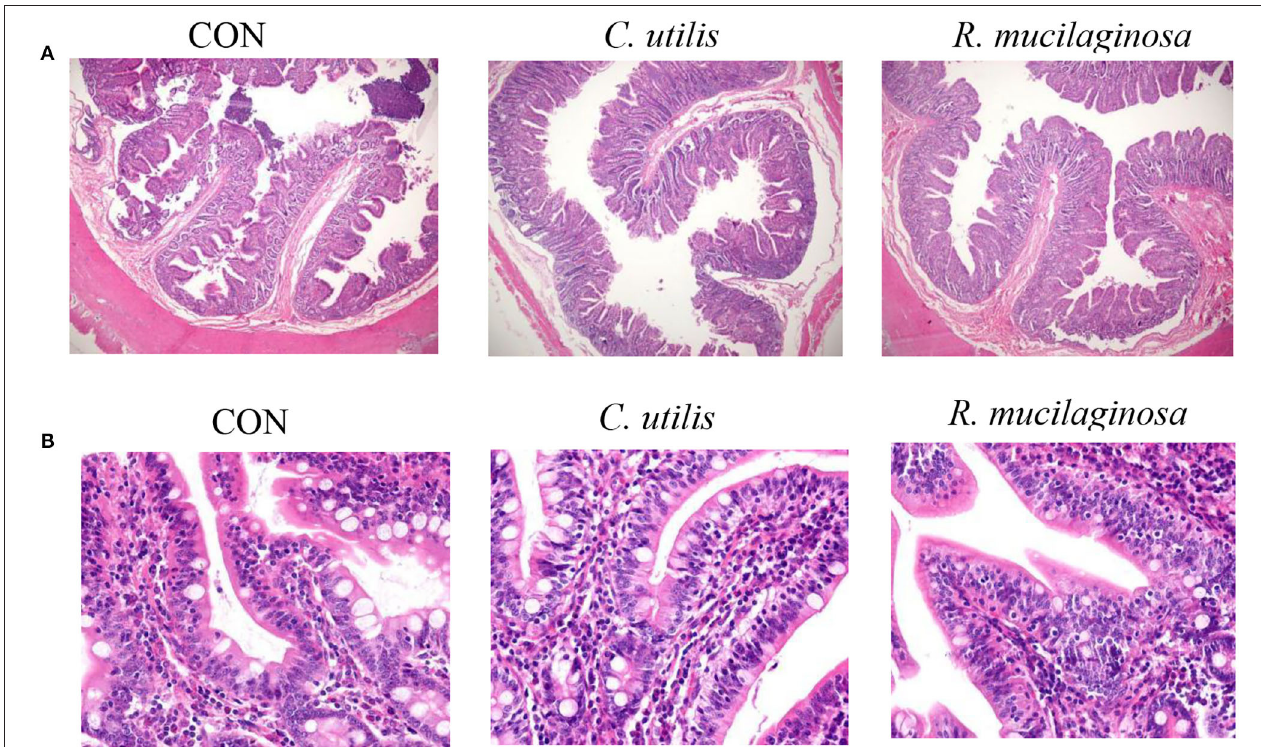
FIGURE 3 | Effects of C. utilis DSM 2361 and R. mucilaginosa on ileum morphology by magnification 40 × (A) and 400 × (B) in weaned piglets. CON, piglets were fed a corn-and a soybean-based basal diet; C. utilis , piglets were fed a soybean-based basal diet and orally administrated 1ml 1.0 × 10 10 CFU/ml C. utilis DSM 2361 three times; R. mucilaginosa , piglets were fed a soybean-based basal diet and daily orally administrated 1ml 1.0 × 10 10 CFU/ml R. mucilaginosa TZR 2014 three times